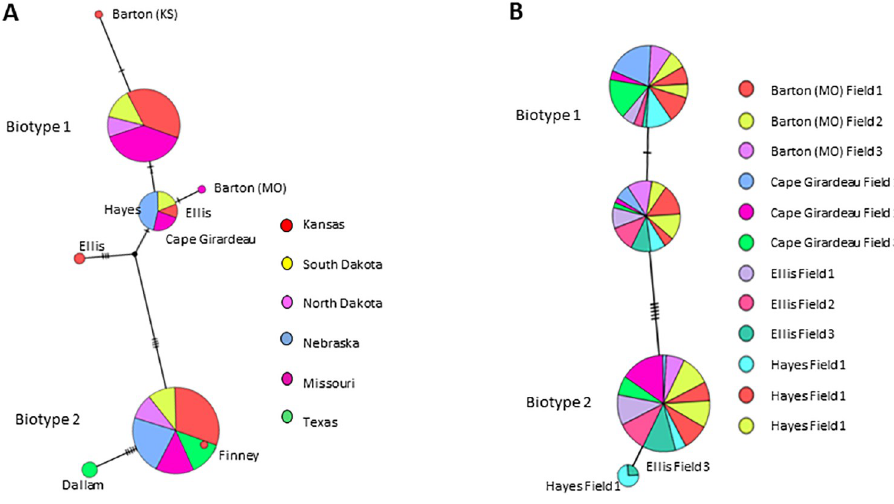
Fig 1. Phylogeny of A . tosichella haplotypes sampled in 2014 and 2015. (A) and 2016 (B) within biotypes 1 and 2. Smaller circles indicate fewer individuals in a haplotype. Hash marks on lines connecting haplotypes symbolize base- pair